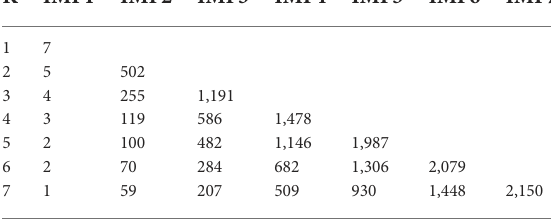
TABLE 4 Center frequencies corresponding to different K values in winter.